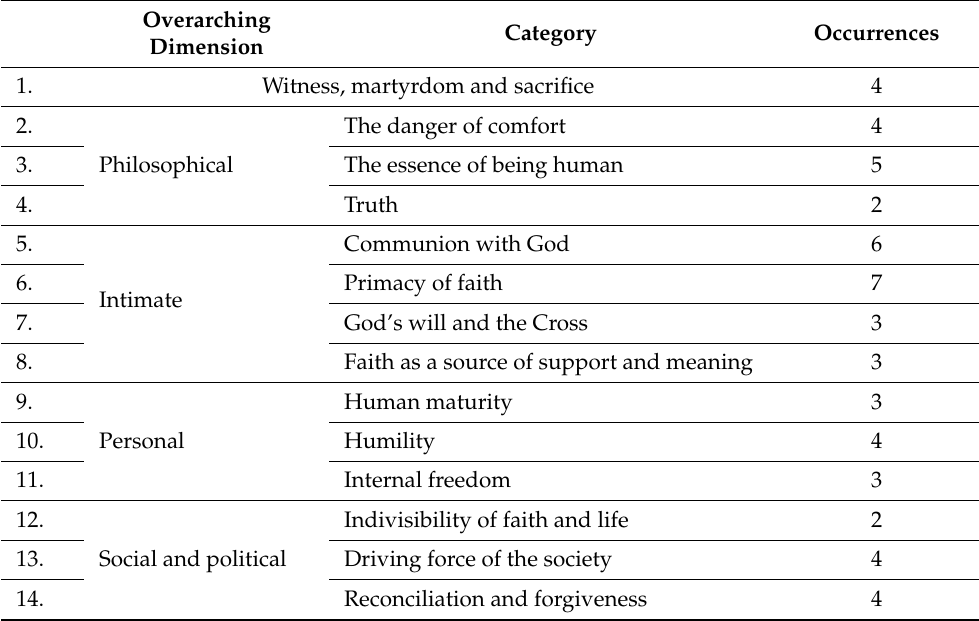
Table 2. Research